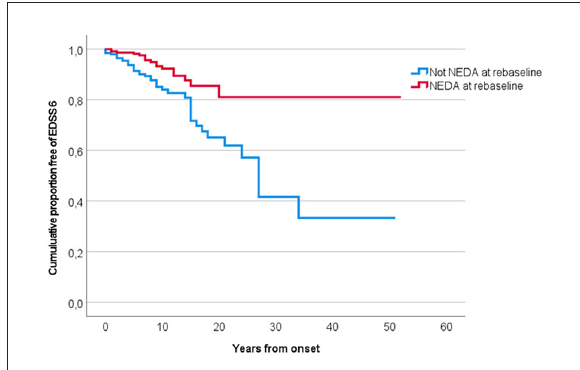
FIGURE5 Time to EDSS 6 in pwMS who achieved NEDA (red) and pwMS who did not achieve NEDA (blue) when rebaselined.